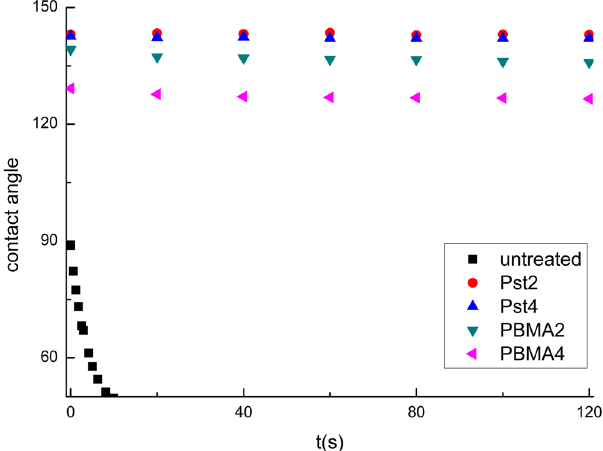
Figure 7. Water contact angles of the samples measured on